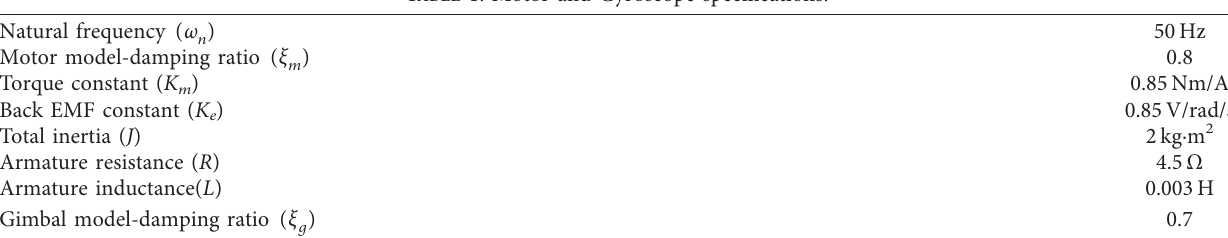
Table 1: Motor and Gyroscope